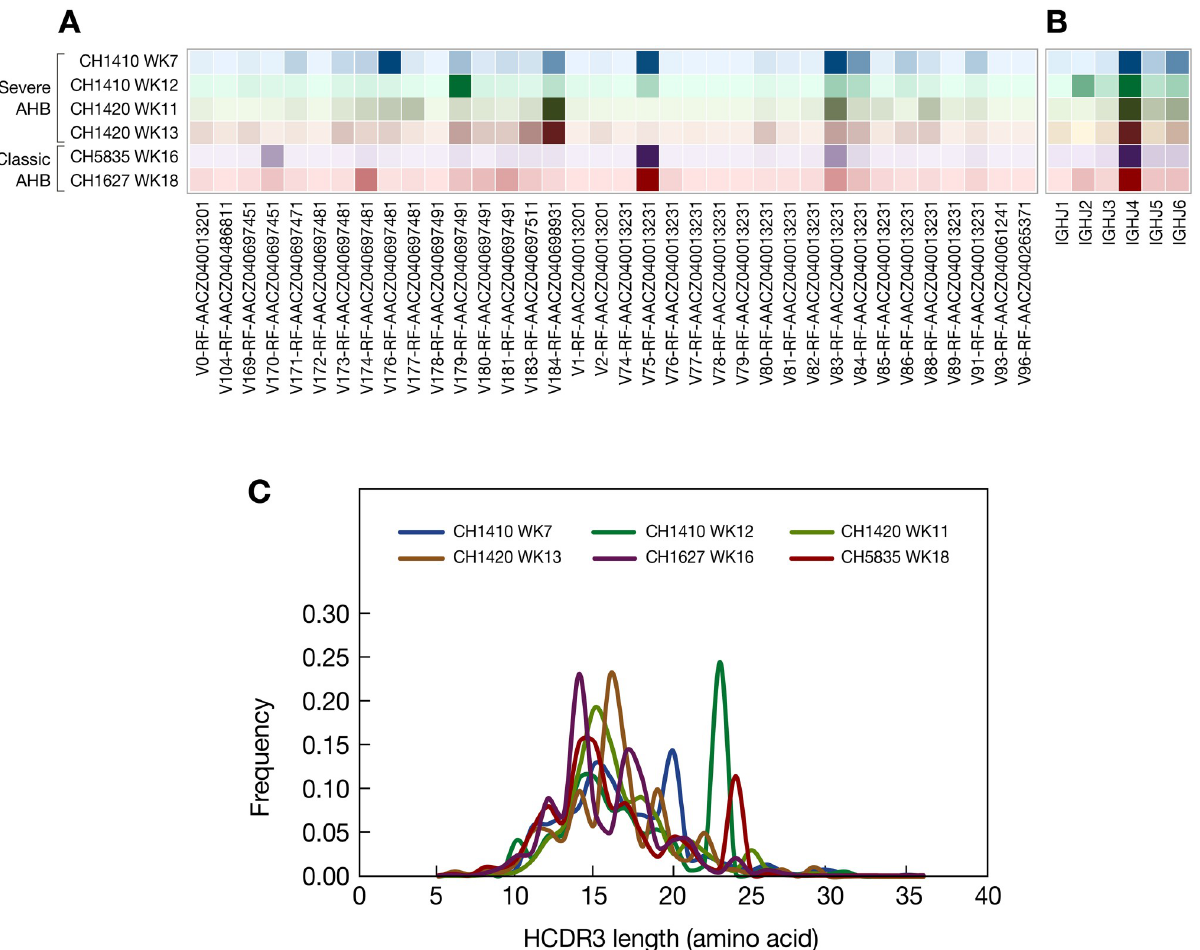
Fig 7. Comparison of the antibody repertoires in the livers of four chimpanzees between severe and classic AHB at different time points during the course of HBV infection. (A) V gene usage by individual chimpanzee. (B) J gene usage by individual chimpanzee. Increased color intensity indicates higher frequency of gene usage. Chimpanzees are colored as in panel C. (C) HCDR3 length distribution of IgG for each chimpanzee. CDRH3 lengths were determined using the Immunogenetics (IMGT) numbering scheme.